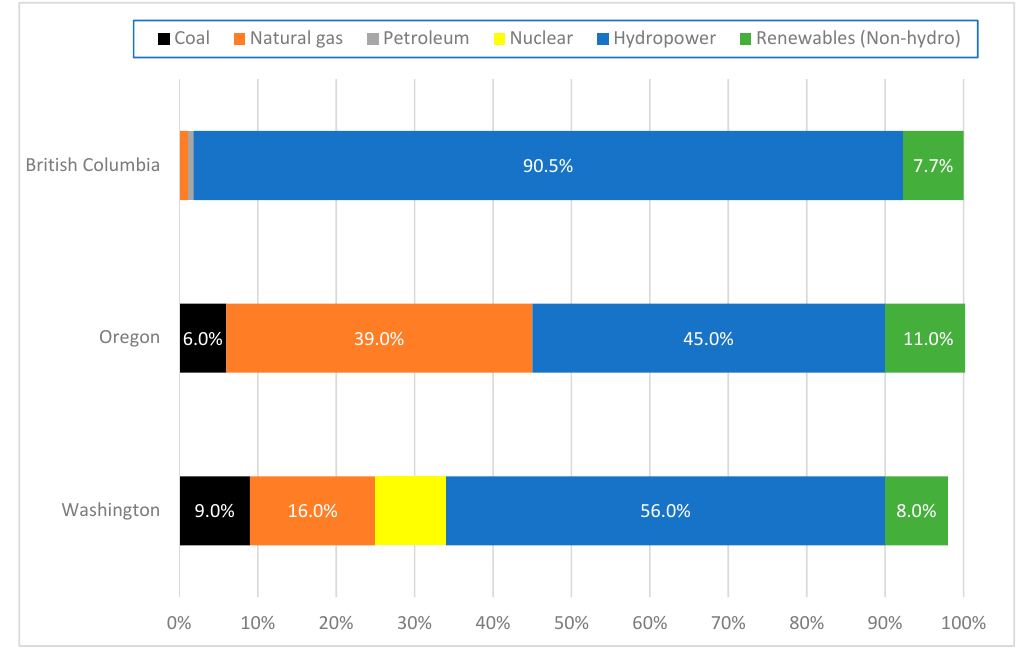
Figure 1. Electricity production by source in British Columbia (BC), Oregon (OR), and Washington (WA), 2019 [31,102,103].